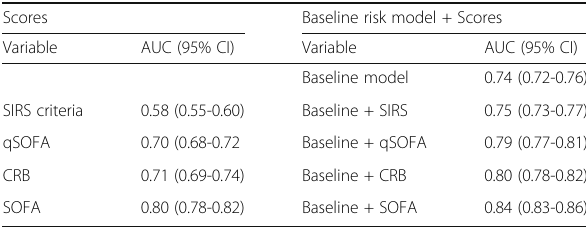
Table 10 (abstract A8). Discrimination